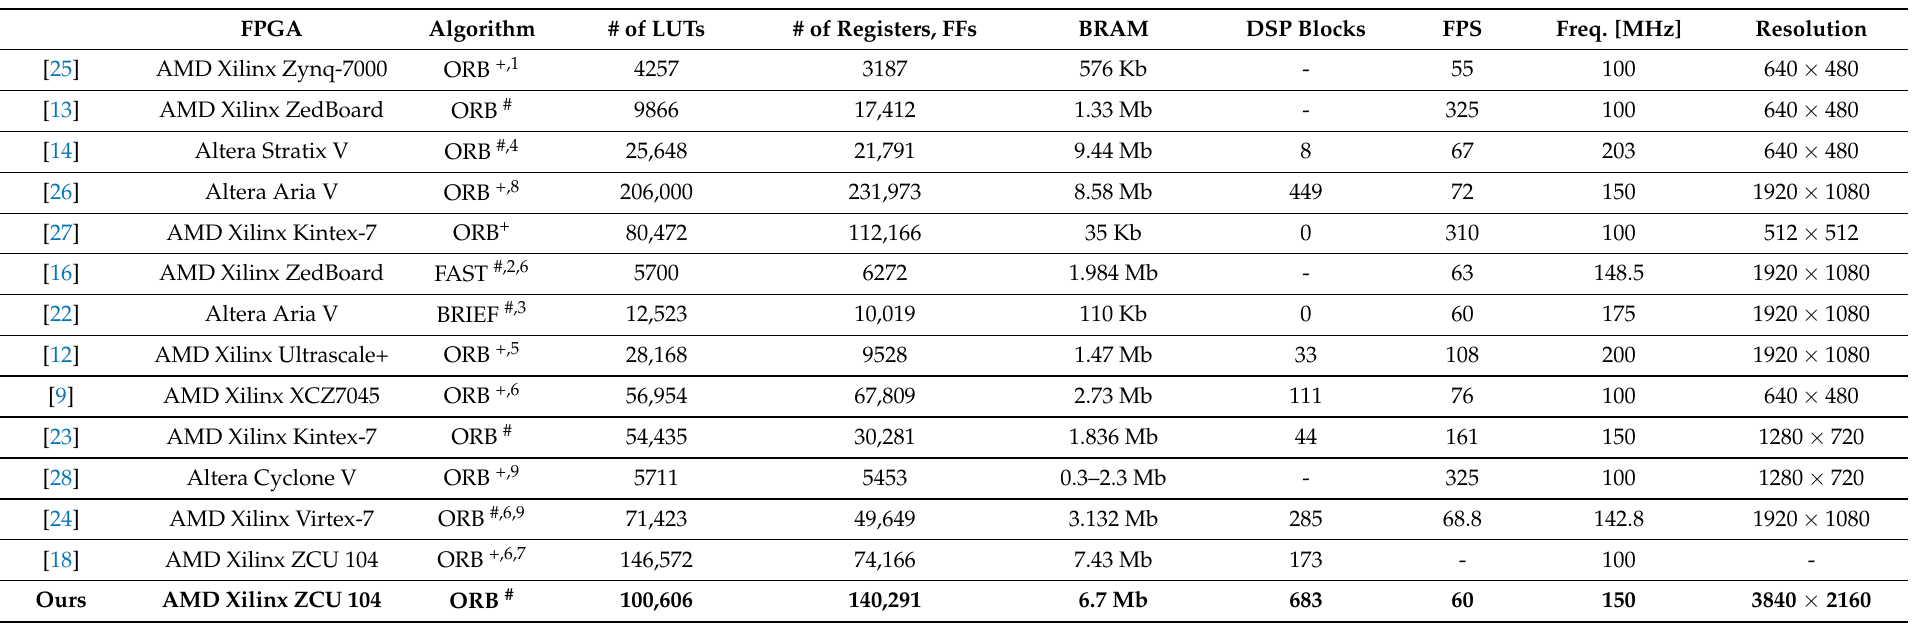
Table 3. Comparison of our proposed solution with other algorithms reported in scientific papers. A direct comparison of our implementation can only be made with works that also use video pass-through architectures, i.e., [13,14,16,22–24]. In comparison to previous works, we use noticeably more FFs and DSP blocks. This is due to the 4 ppc real-time implementation of the BRIEF